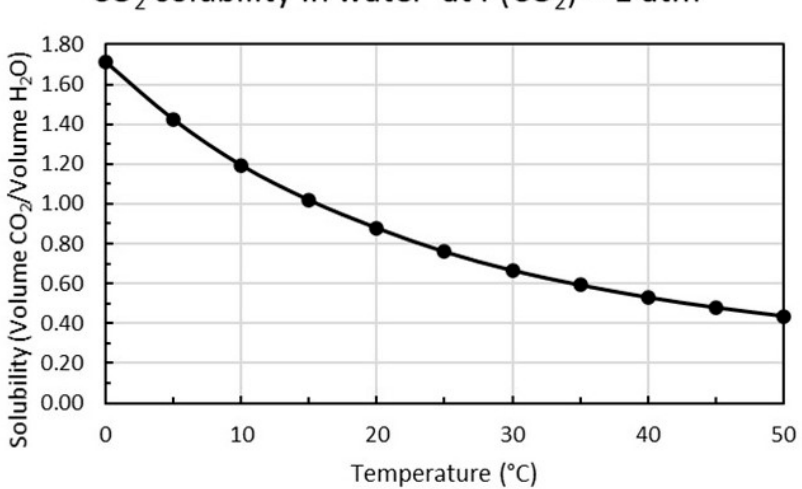
Figure 4. Dissolved CO 2 versus temperature (°C) for carbon dioxide pressure P (CO 2 ) = 1 atm plotted from tabular data [14].